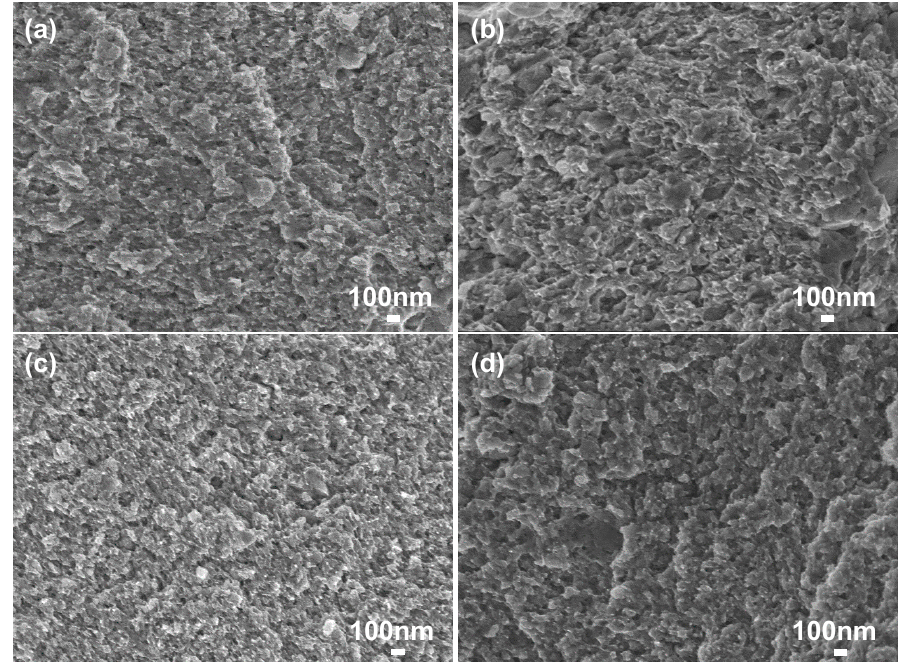
Figure 8. Fracture surfaces of 20 vol % TiC ( a ) Cu–TiH2–C nanocomposite sintered at 900 °C; ( b ) Cu–